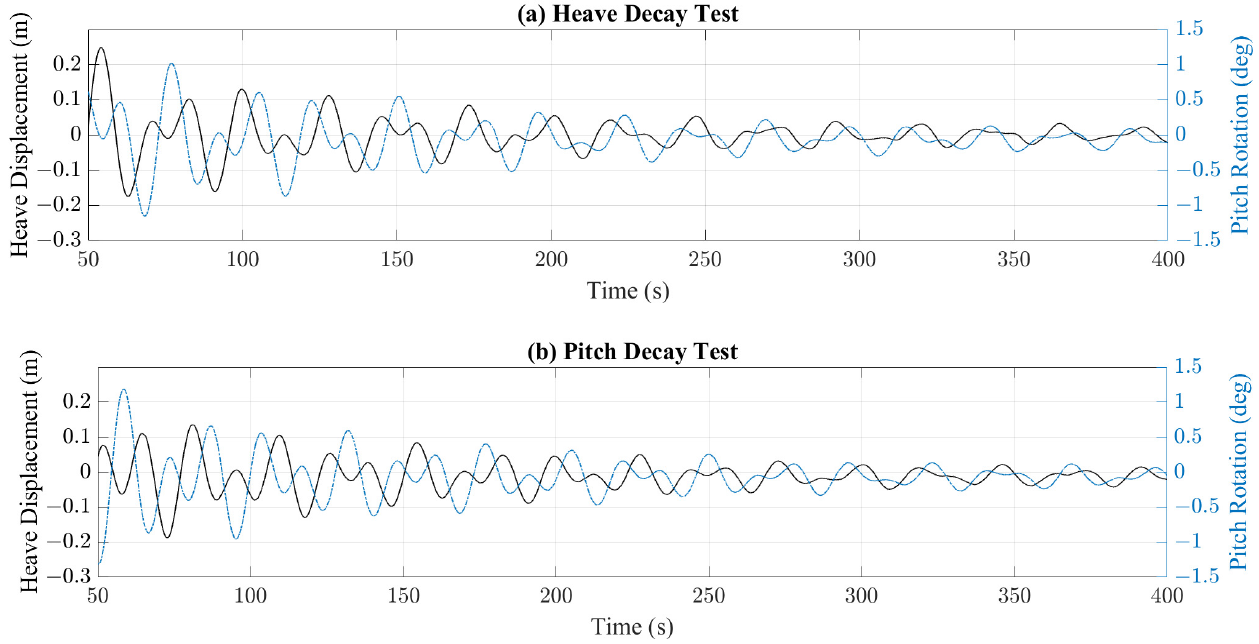
Figure 3. Time series of experimental free decay tests: ( a ) heave-free decay test and ( b ) pitch-free decay test.